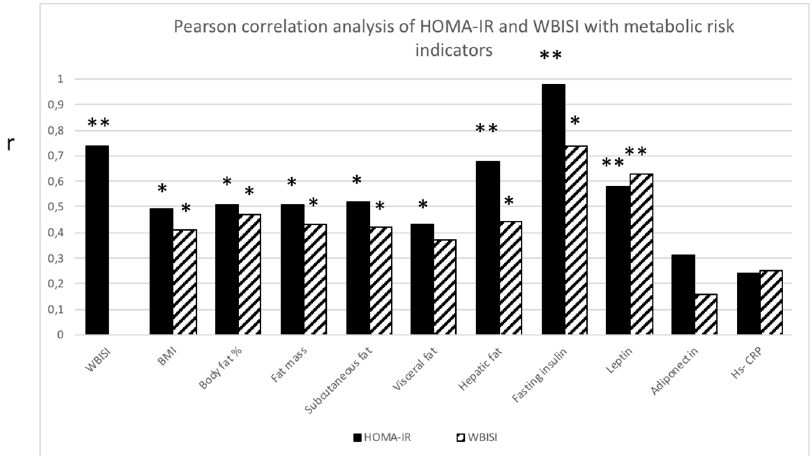
Figure 2. Pearson correlation analysis between homeostasis Model Assessment Insulin Resistance (HOMA-IR; black bar) and Whole Body Insulin Sensitivity Index (WBISI; striped bar) with metabolic risk indicators. Significant correlation (r) between HOMA-IR or WBISI with metabolic risk indicators. * p ≤ 0.05 ** p ≤ 0.01.